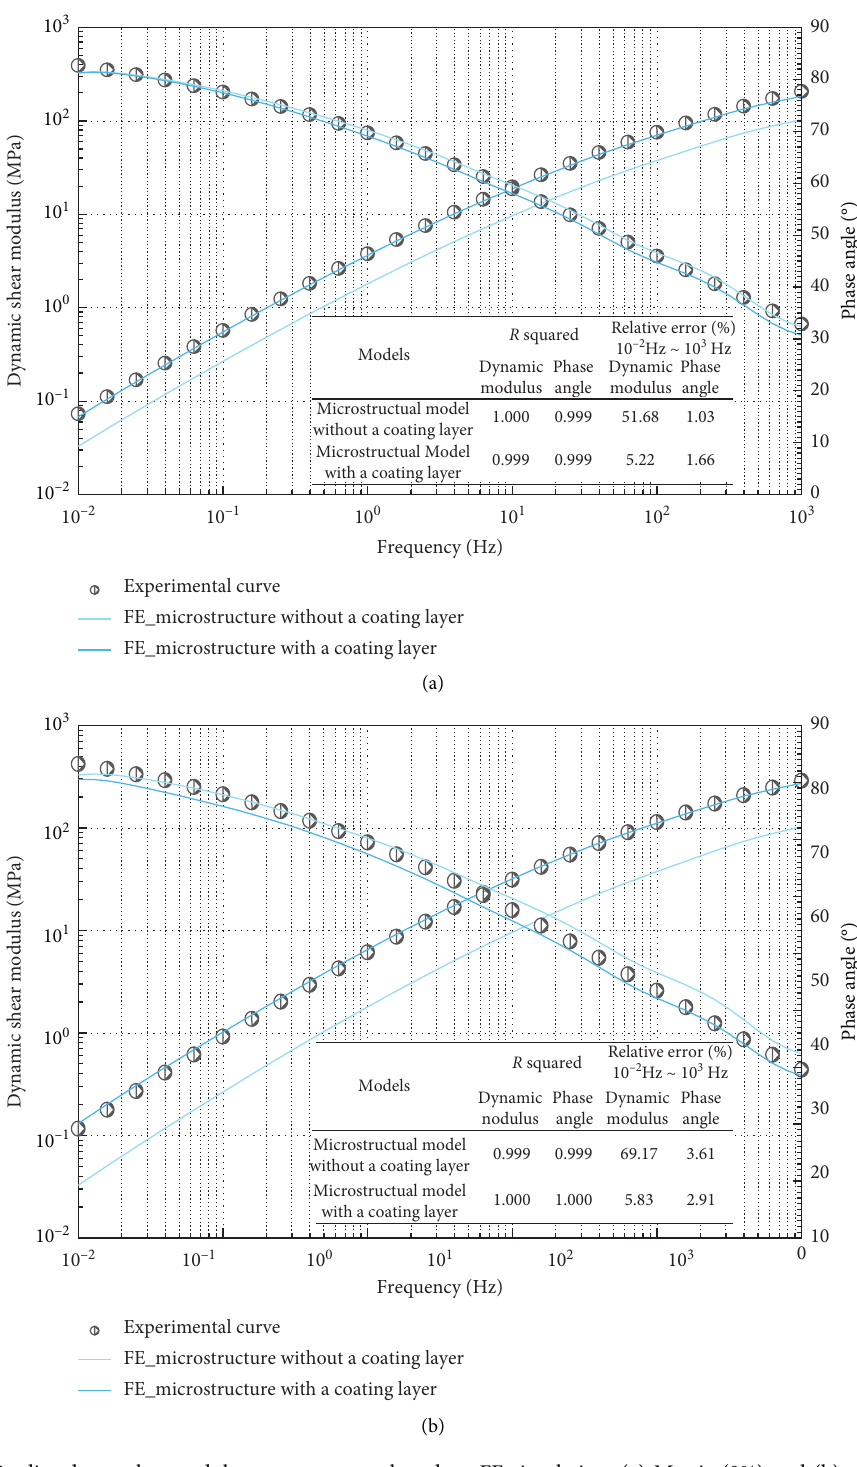
Figure 12: Predicted complex modulus master curves based on FE simulation. (a) Mastic (0%) and (b) mastic